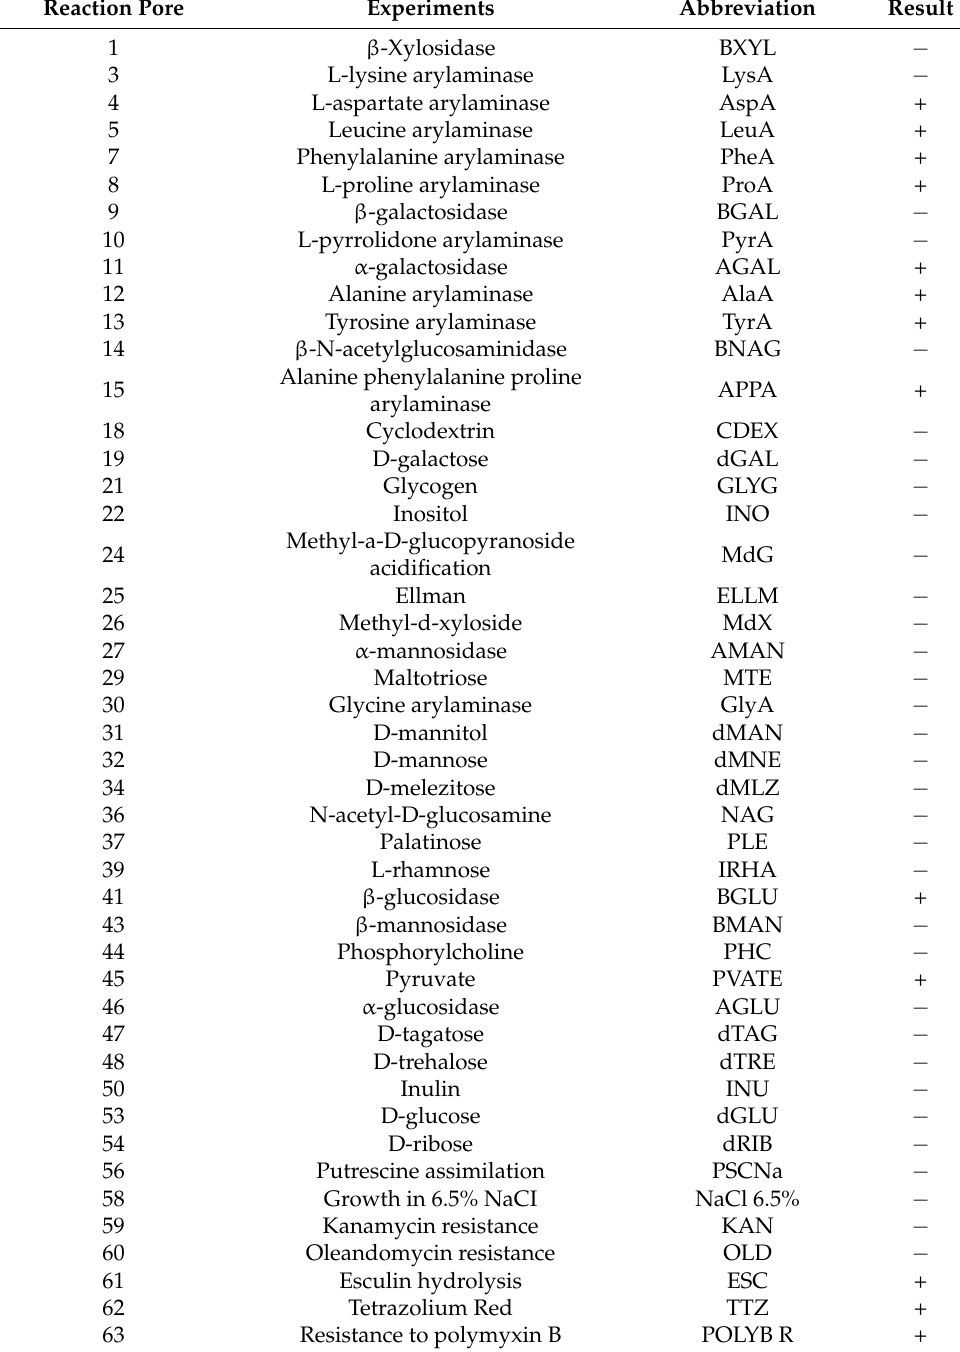
Table 1. Enzyme activity, carbon source utilization, inhibition, and drug resistance of WangLB